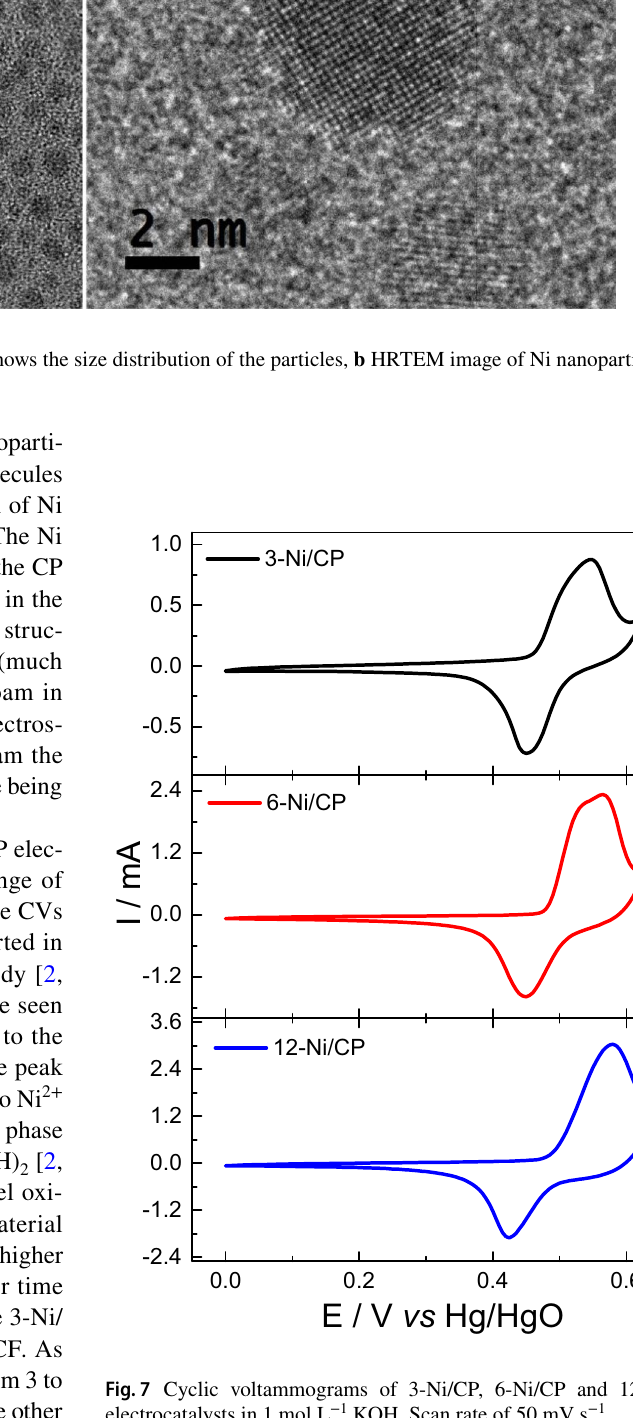
Fig. 7 Cyclic voltammograms of 3-Ni/CP, 6-Ni/CP and 12-Ni/CP electrocatalysts in 1 mol L −1 KOH. Scan rate of 50 mV s